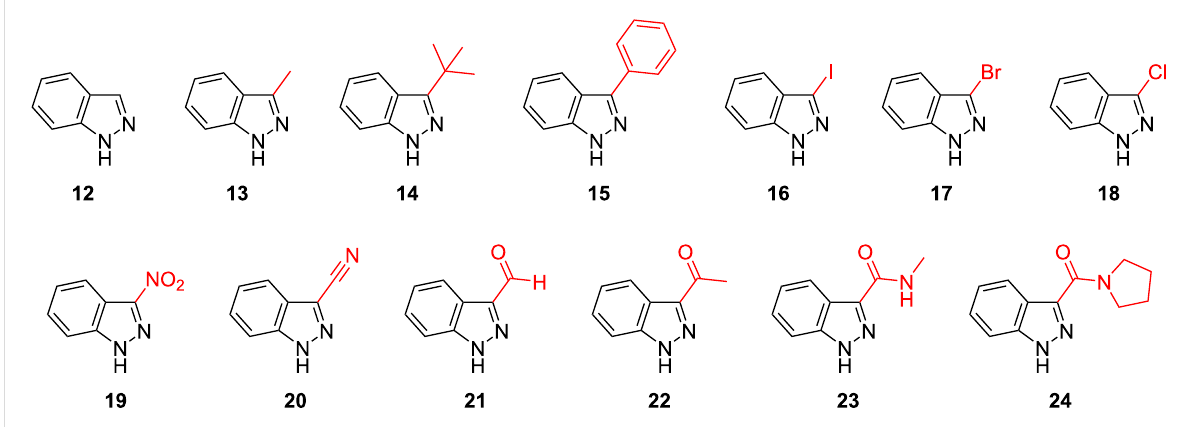
Figure 3: C-3 substituted indazole derivatives ( 12 – 24 ) employed to investigate C-3 substituent effects on indazole N -alkylation regioselectivity.